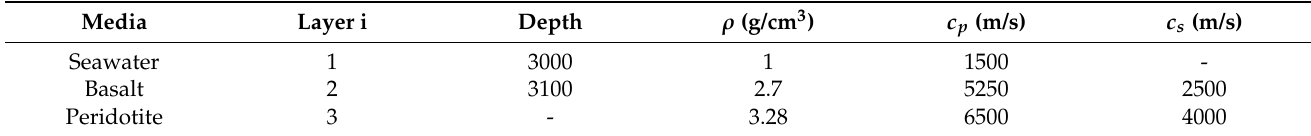
Table 1. Parameters of the marine environment.